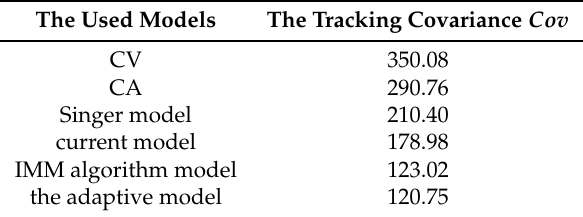
Table 3. Comparison on tracking covariance of different models with UKF estimation method.